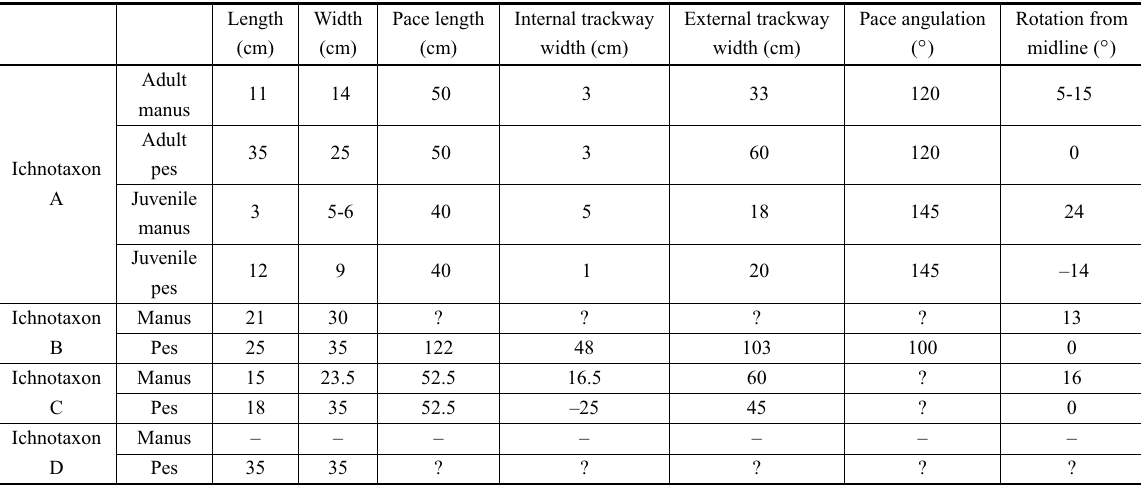
Measurements of the Tunasniyoj tracks. (?) unknown. (–) not applicable. Length Width Pace length Internal trackway External